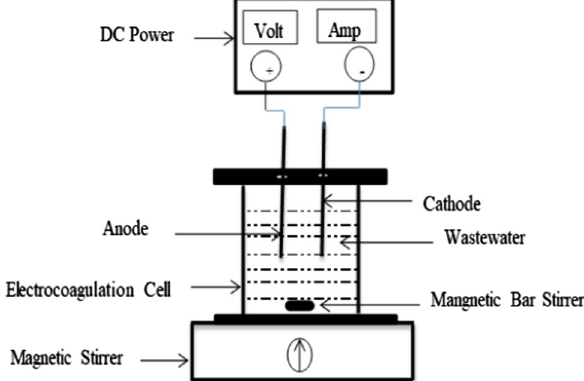
Fig. 1 Electrocoagulation